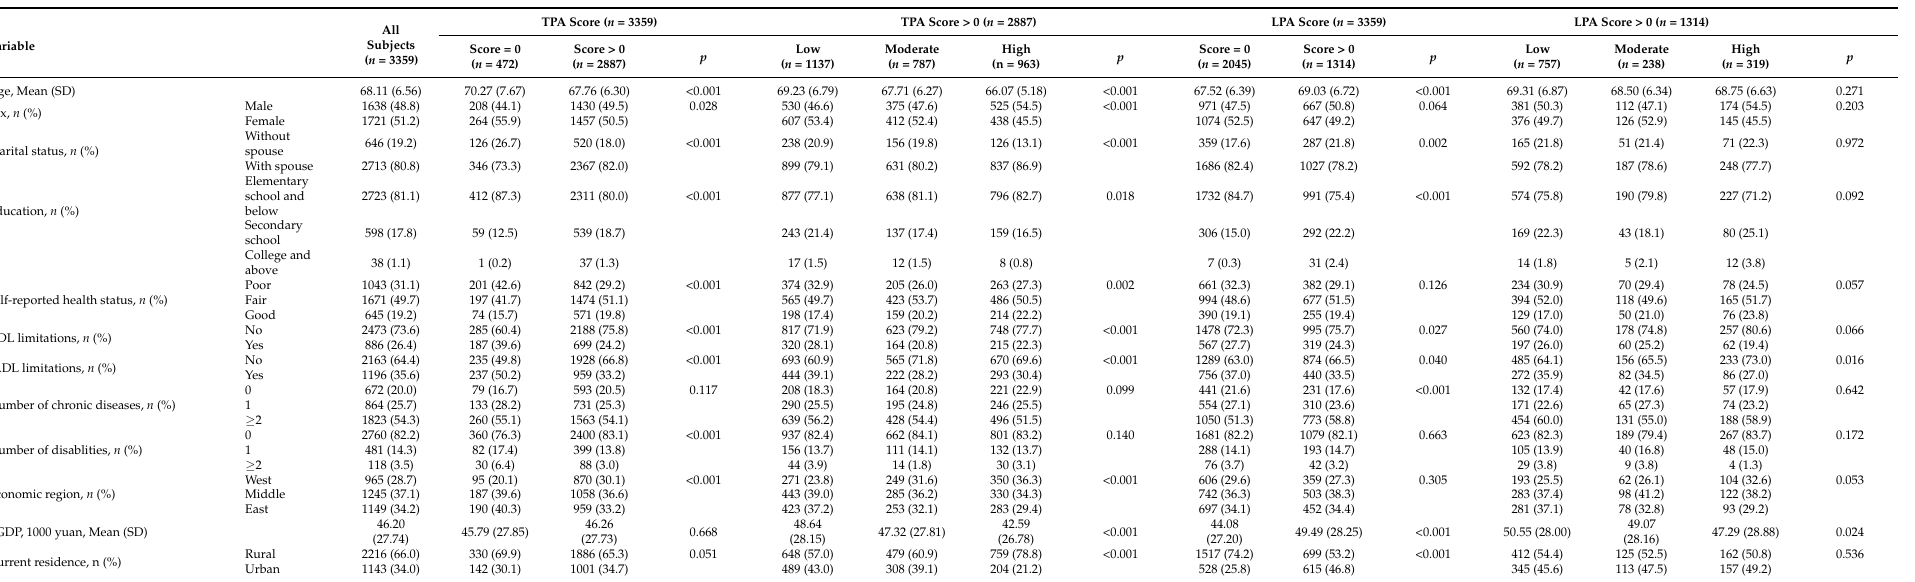
Table 1. Characteristics of study participants.